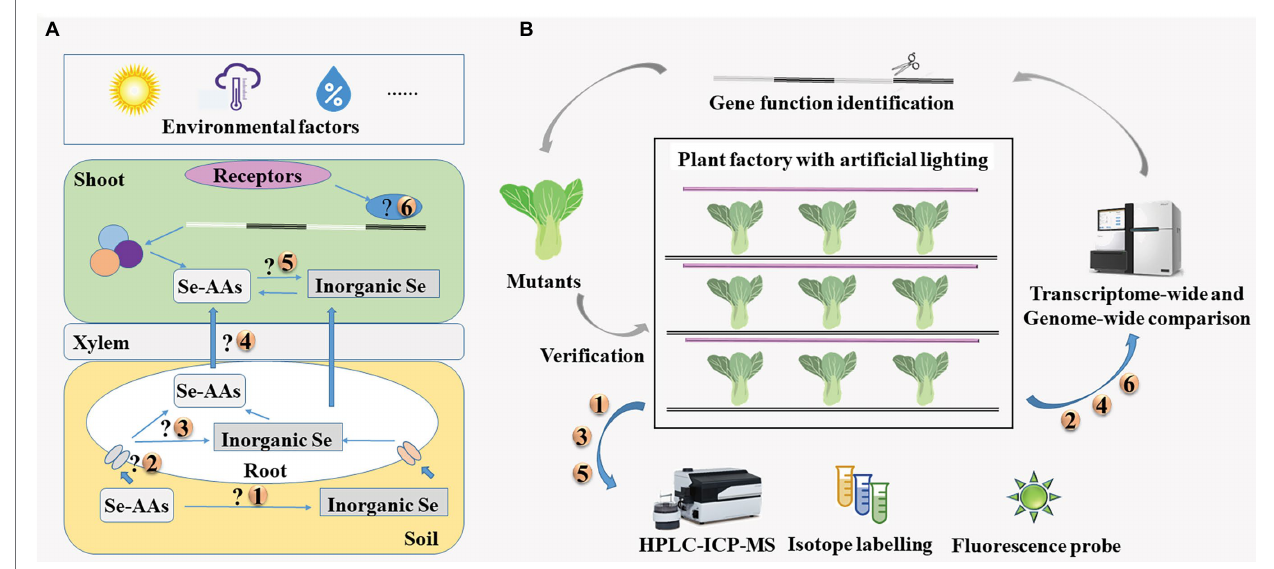
FIGURE 4 | (A) Key issues in research of seleno-amino acids in vegetables and (B) the proposed strategies to address these issues. HPLC-ICP-MS, high- performance liquid chromatography in conjunction with inductively coupled plasma mass spectrometry; Se-AAs, seleno-amino acids; and Se,